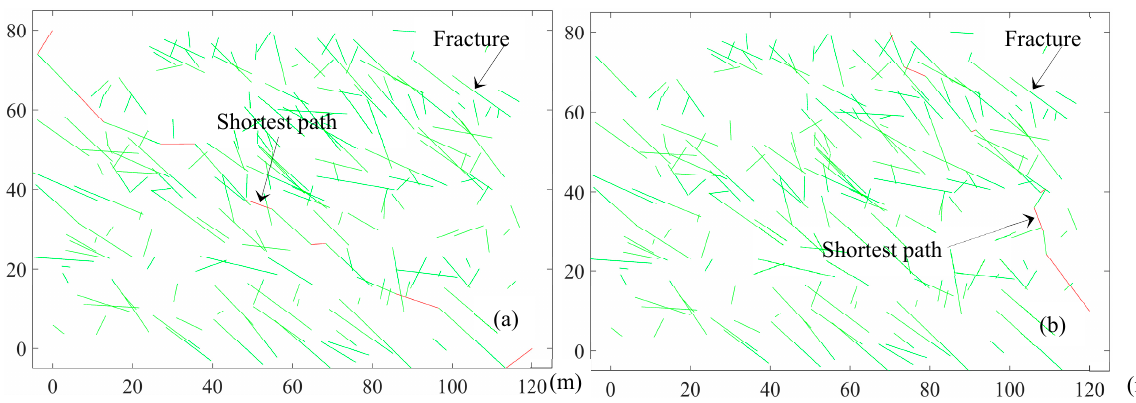
Figure 9. The shortest path between the designated shear entrance and exit; ( a ) Entrance point (0, 80) and exit point (120, 0); ( b ) Entrance point (70, 80) and exit point (120, 10).